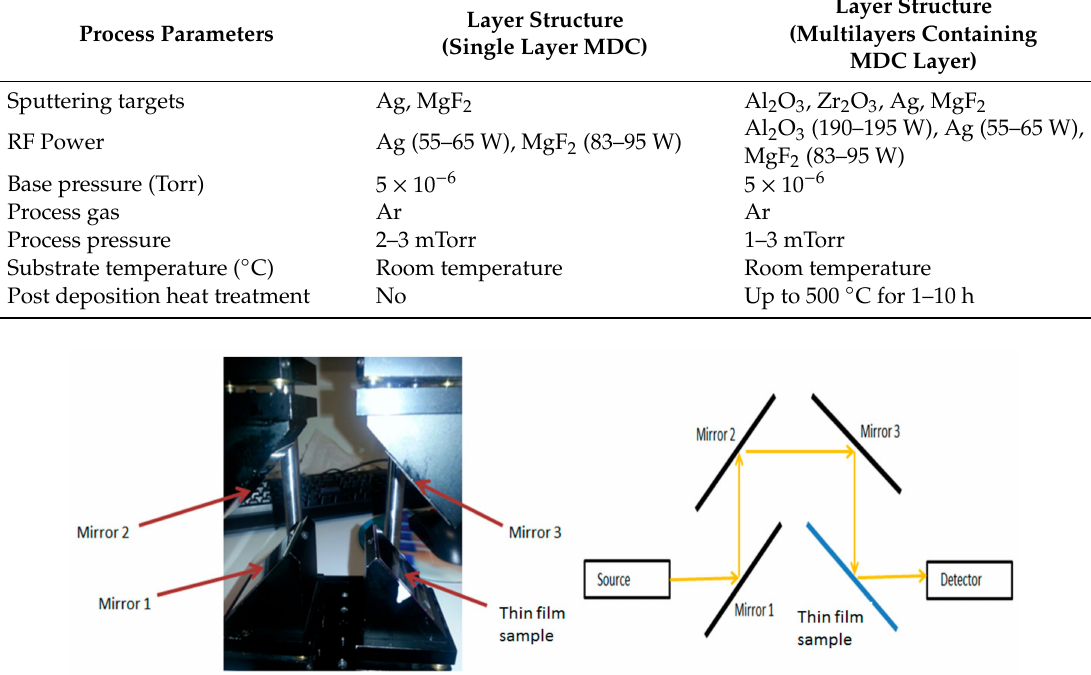
Figure 8. Schematic diagram of the optical system used in Cary 5000 spectrophotometer to measure the reflection spectrum of the thin-film coatings on glass